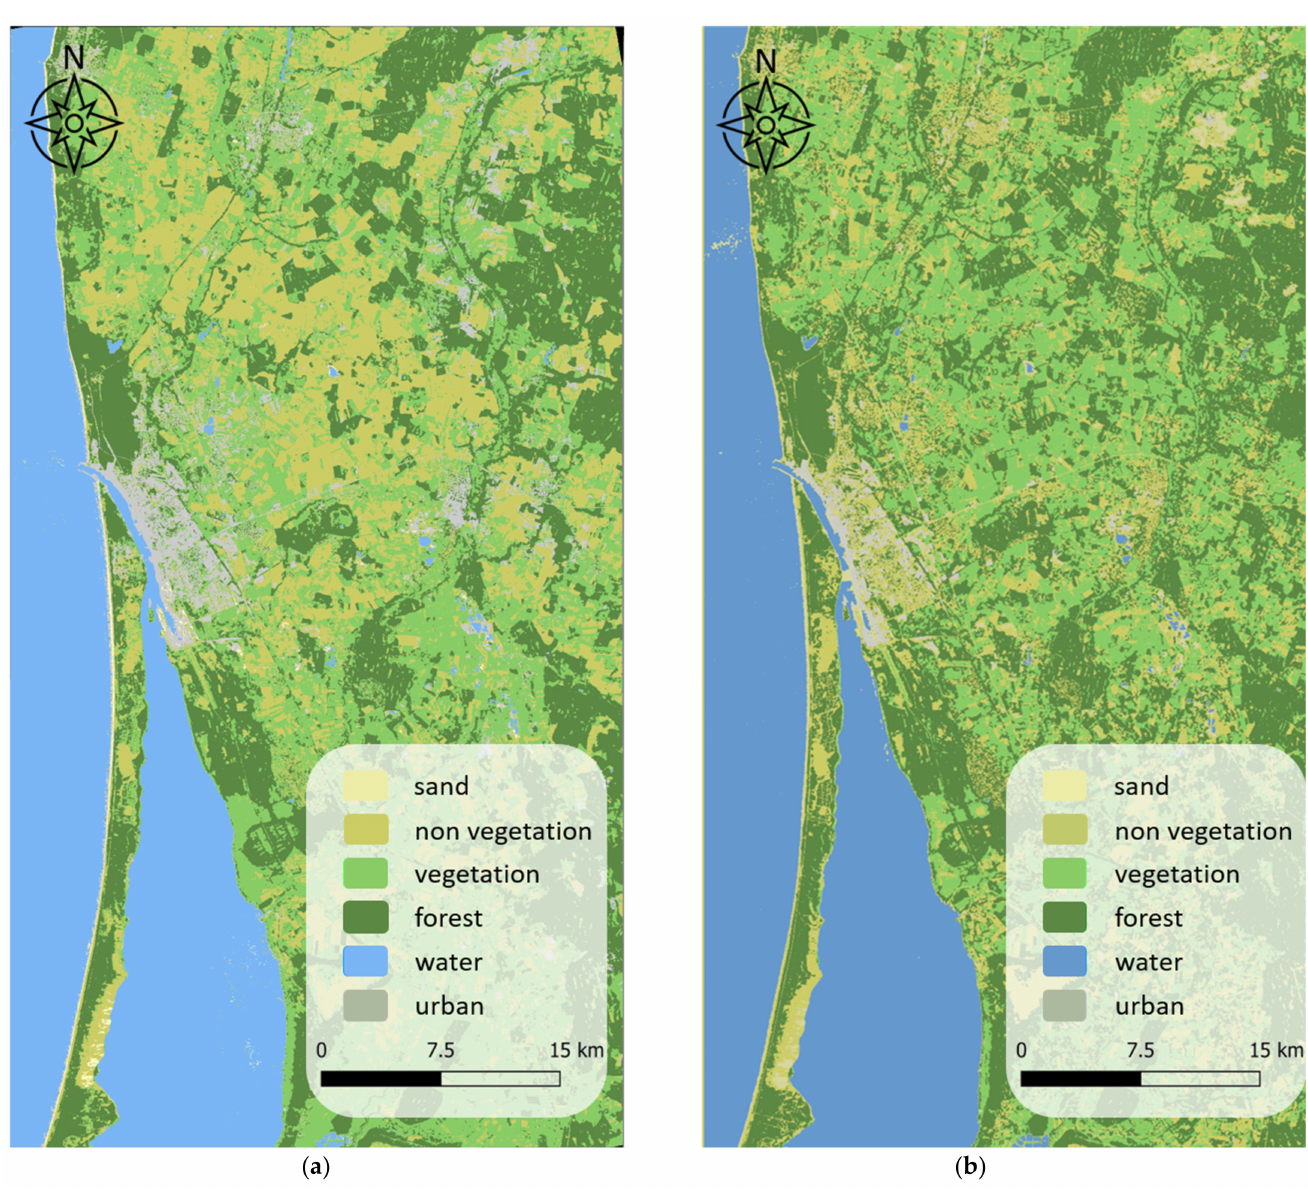
Figure 12. Segmentation result: ( a ) 2018; ( b )